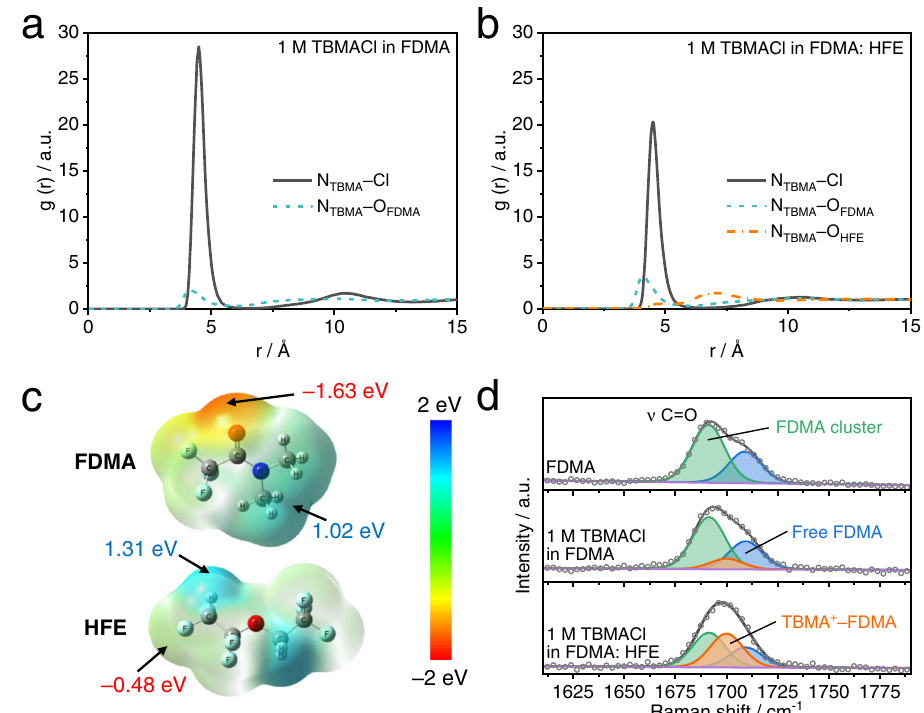
Fig.3|Solvationstructuresofelectrolytes.a,b RDFsofTBMA + – coordinationpairsobtainedfromMDsimulationsfor a 1MTBMAClinFDMAand b 1MTBMAClinFDMA: HFE electrolytes. c ESP distributions of FDMA and HFE molecules. d Raman spectra of FDMA solvent and different electrolytes at